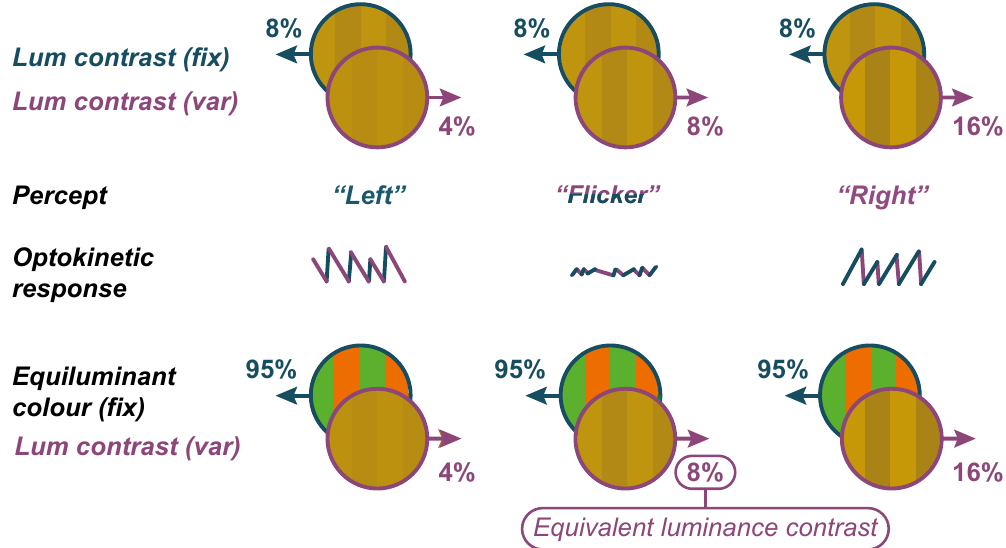
Figure 1. (Top row) Two superimposed gratings moving in opposite directions, with the contrast of one grating fixed (here at 8%) and the other varying. (middle rows) The observer’s optokinetic response to the summed gratings, generally follows the direction of the grating that appears higher-contrast. When the contrasts are perceptually matched the observer perceives only flicker, and the motion of the fixed grating is "nulled". (bottom row) A relatively low contrast (here 8%) luminance-defined grating can null the motion of a high-contrast equi- bright colour